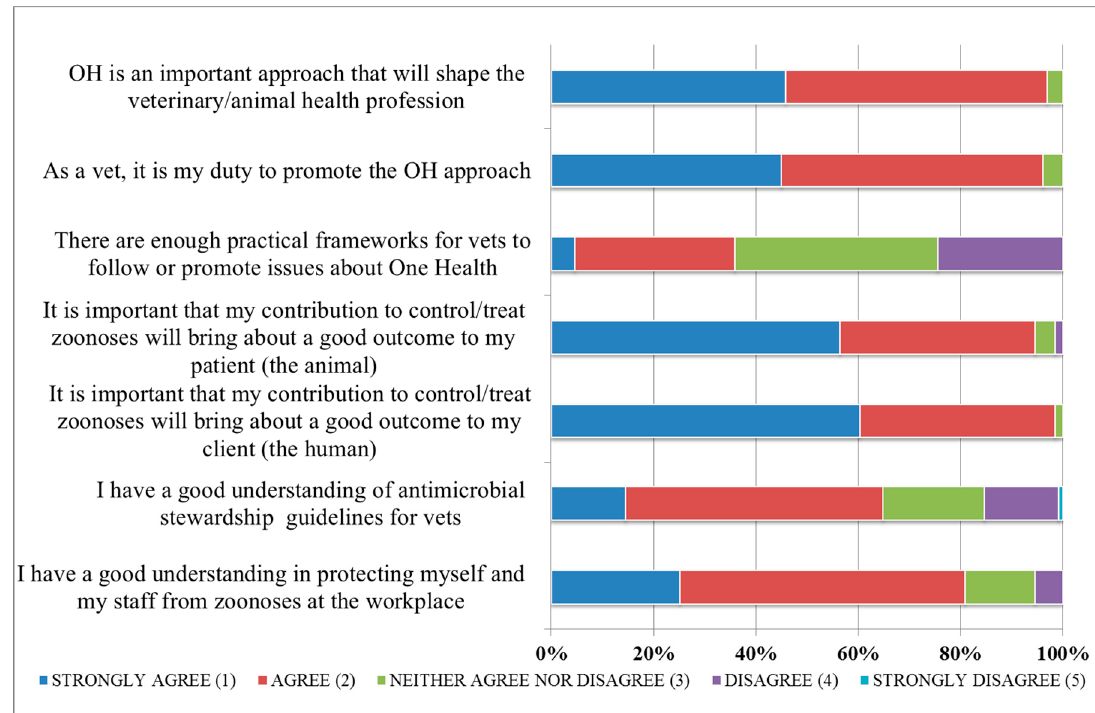
Figure 1. Perceived beliefs and attitudes expressed by 175 senior veterinary student respondents.